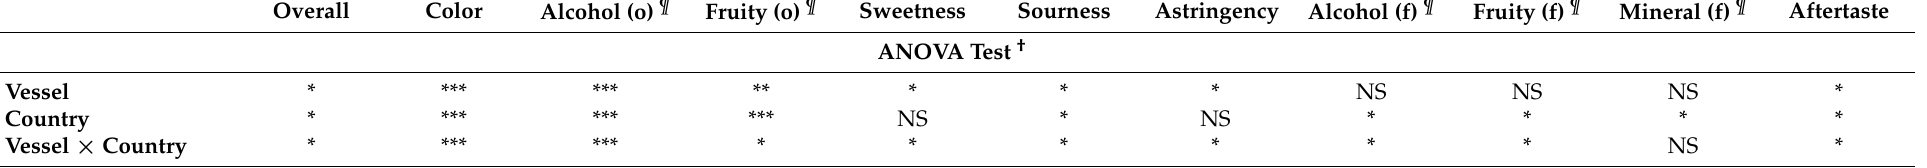
Table 3. Liking scores of the main attributes of the studied wines as affected by the type of vessel used for the aging step ( A : aged in clay- tinaja with non-permeable inner coating; B : aged in clay- tinaja without inner coating; C : aged in oak